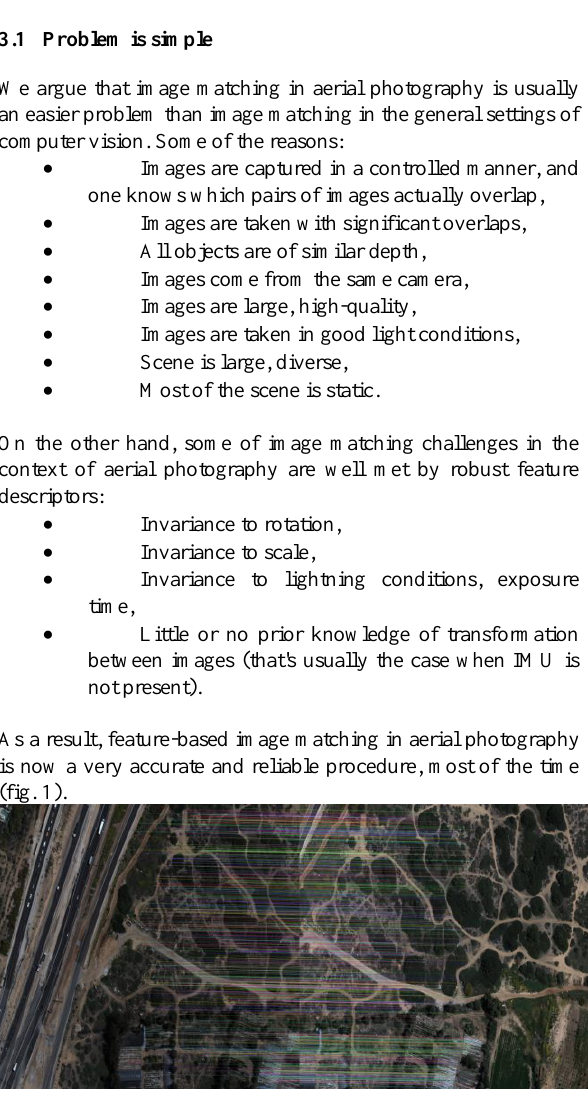
Figure 1: Typical problem; numerous correct tie-points